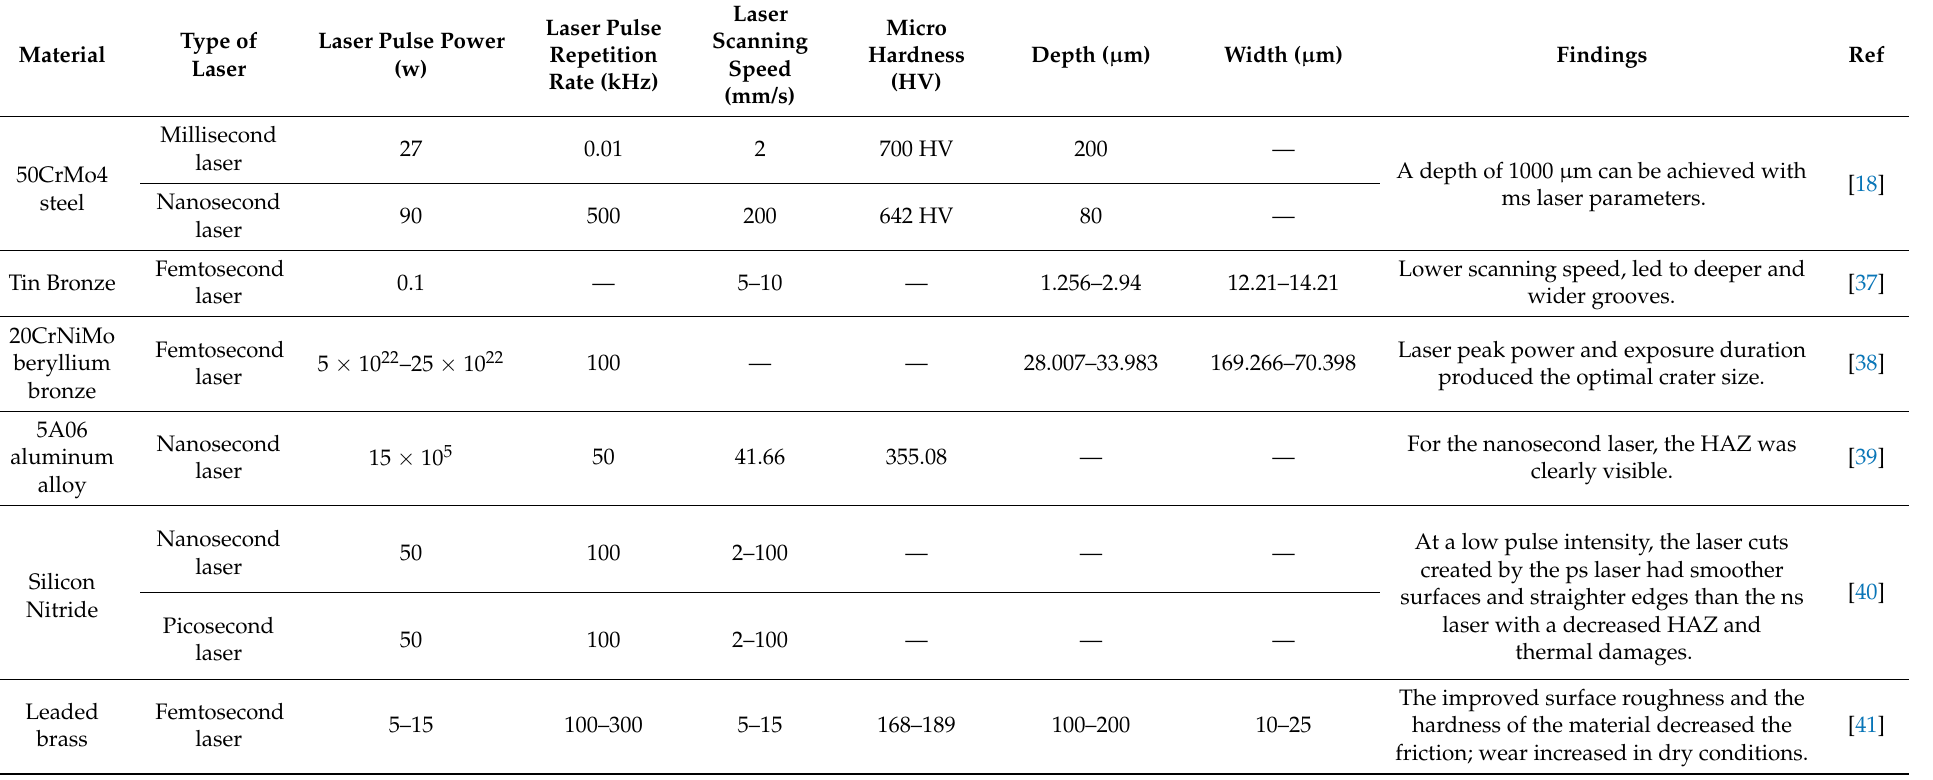
Table 1. Analysis of different types of lasers with respect to the laser parameters and nature of the